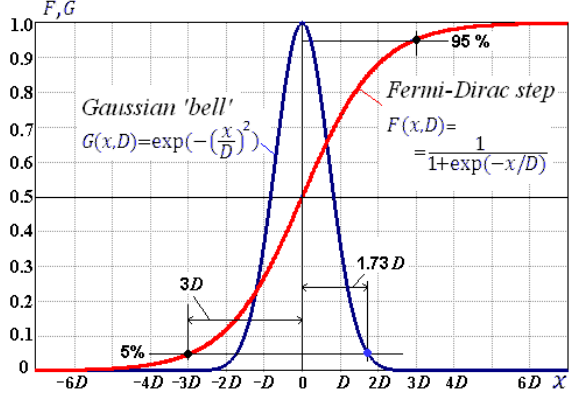
Table 2. Characterization of the seven selected data sets for model